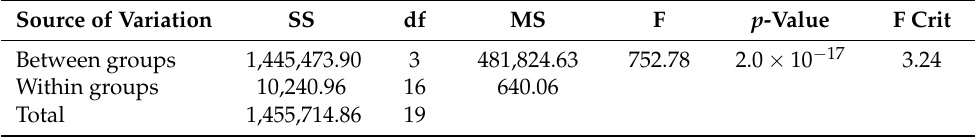
Table 8. Resulting ANOVA table for carbon laminates under testing temperatures of 25–100 ◦ C.